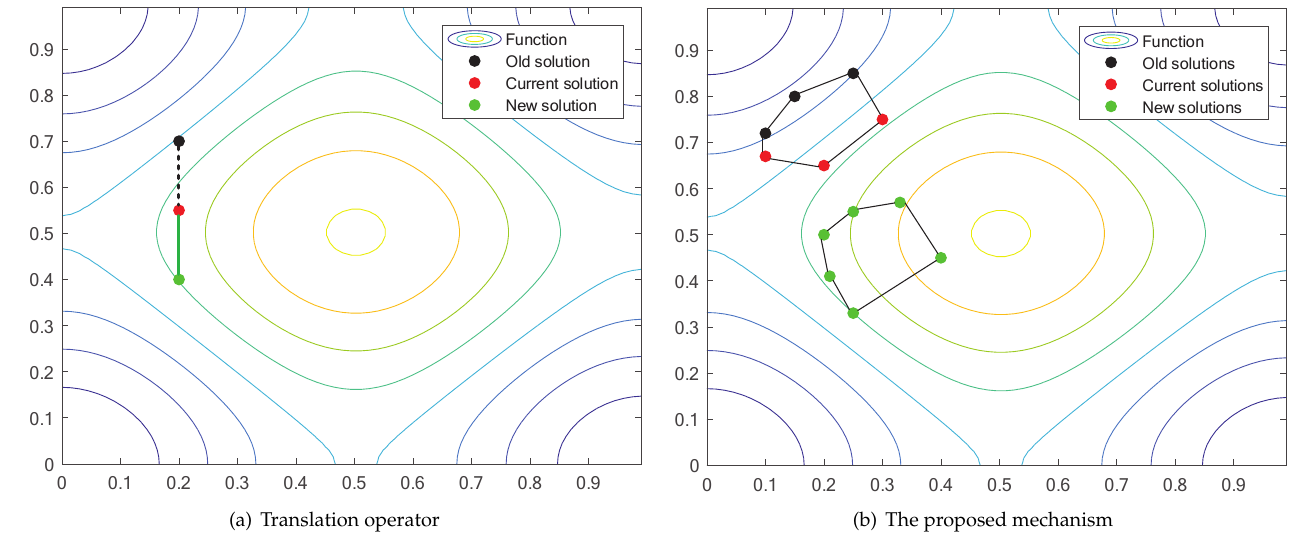
Figure 2. Comparison in utilizing history